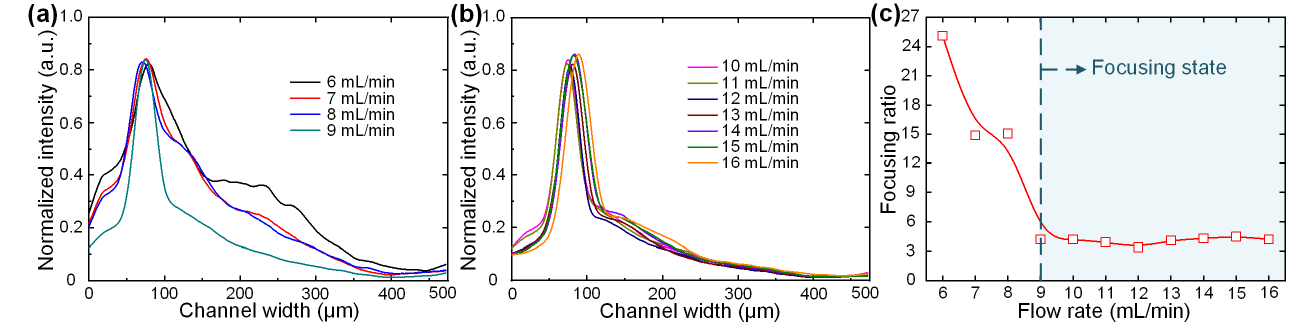
Figure 3. ( a , b ) Normalized fluorescence intensity profiles across the channel width at flow rates of ( a ) 6–9 and ( b ) 10–16 mL/min. ( c ) Focusing ratios at increasing flow rates. Particles were regarded as in focusing state in the device after the flow rate reached 9 mL/min.